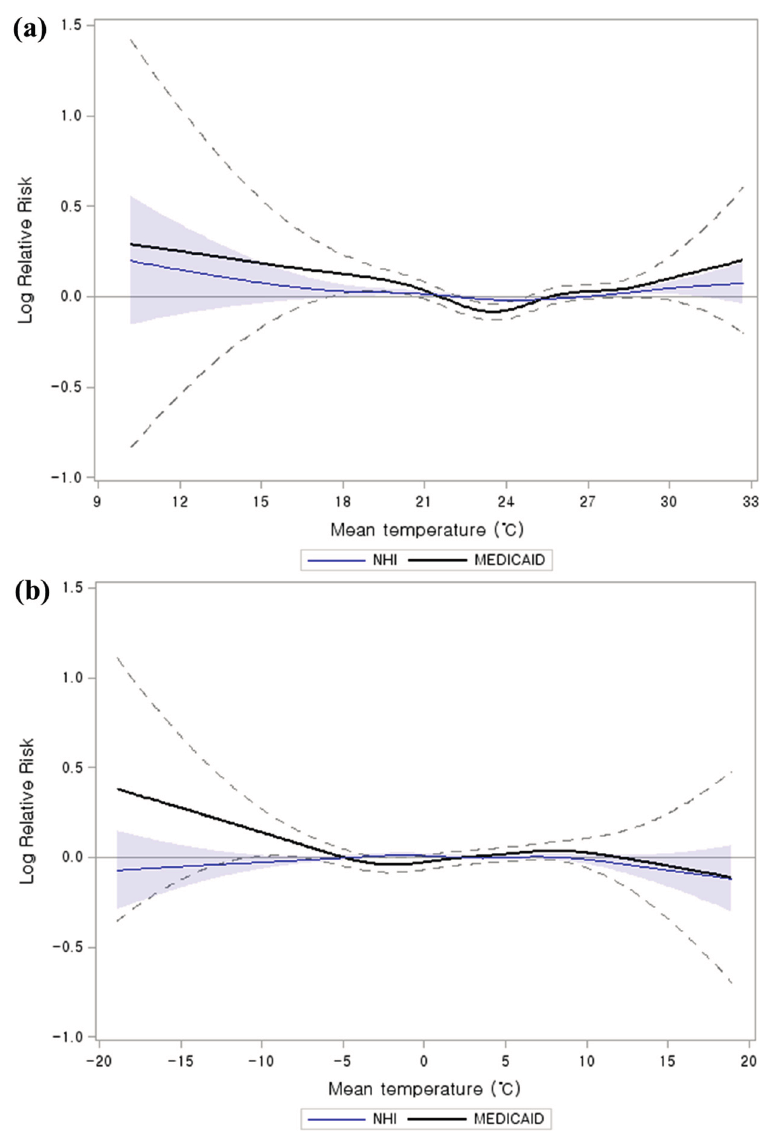
Figure 1. Comparison of Medicaid and NHI on the relationship between mean temperature (lag 0) and AMI hospital admissions. The curve shows smoothing spline of mean temperature with 3 degrees of freedom. The model was adjusted for calendar year, day of the week, precipitation, humidity, sea-level pressure, air pollutants (PM 10 , O 3 , NO 2 ), and annual population size: ( a ) hot weather (summer: June–August) ( b ) cold weather (winter: December–February) (Blue areas and black dotted Upper and lower 95% confidence